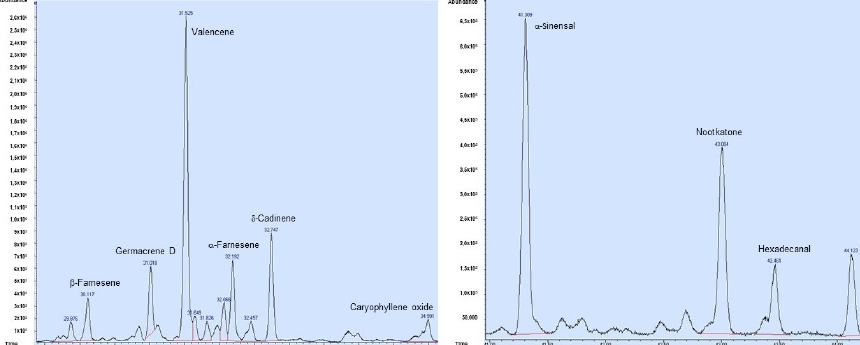
Figure 1. GC chromatogram of orange essential oil obtained using the cold-pressed method followed by steam distillation (EOPD).